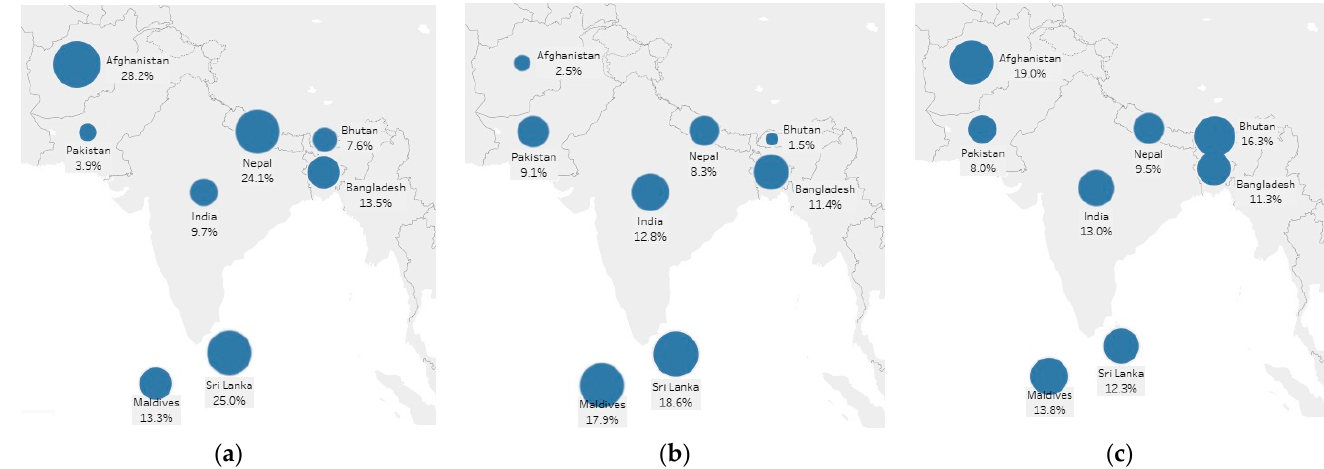
Figure 1. ( a ) Stunting (height ‐ for ‐ age <2 SDs), ( b ) thinness (BMI ‐ for ‐ age <2 SDs), and ( c ) overweight (BMI ‐ for ‐ age >1 SDs) prevalence of adolescents by South Asian country, GSHS data.